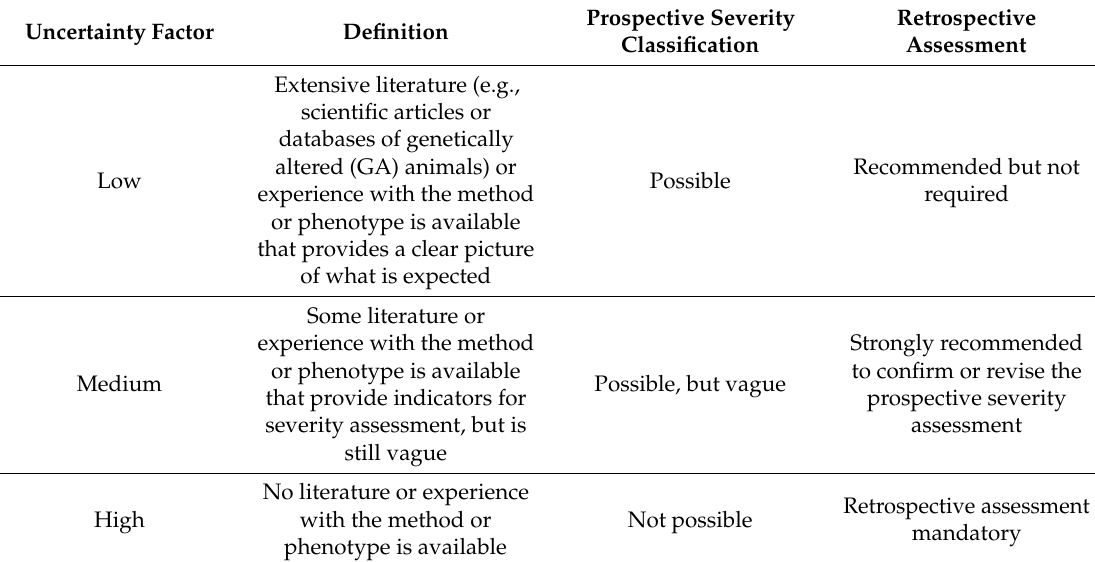
Table 1. Assigning an uncertainty